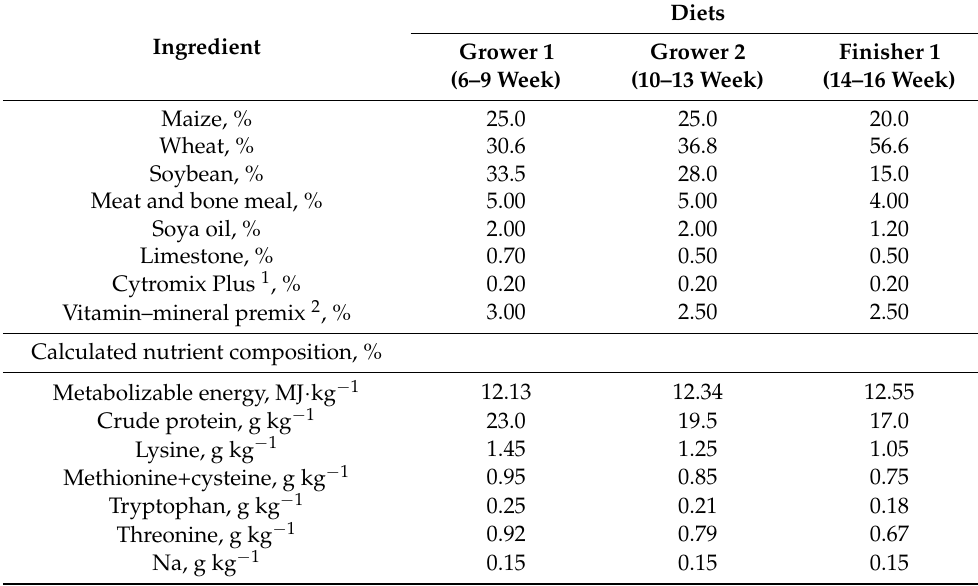
Table 1. Ingredient and nutrient content of the standard experimental diets (g 100 g − 1 , as fed-basic).